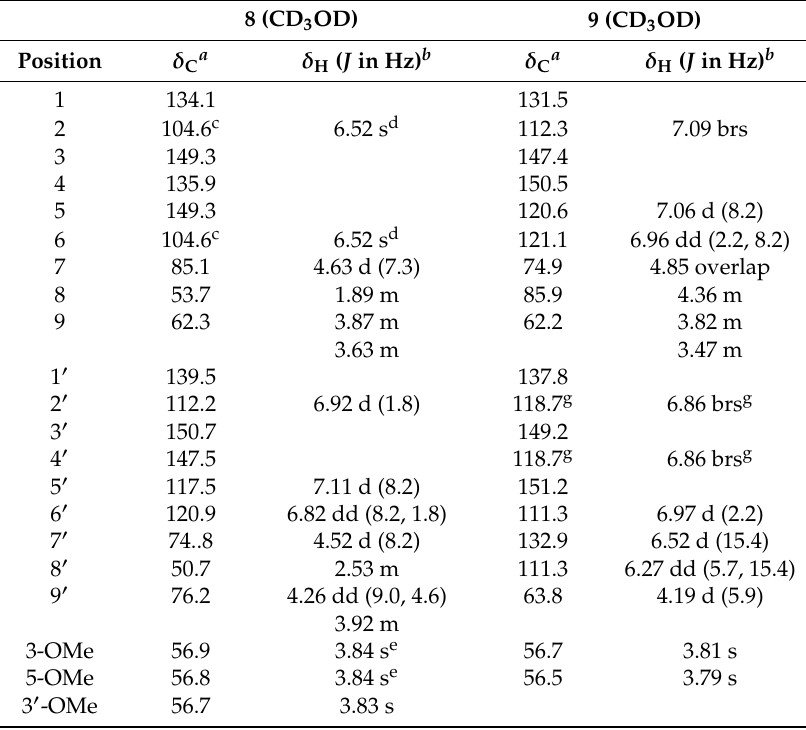
Table 3. 1 H and 13 C NMR Spectroscopic Data of Compounds 8 and 9.